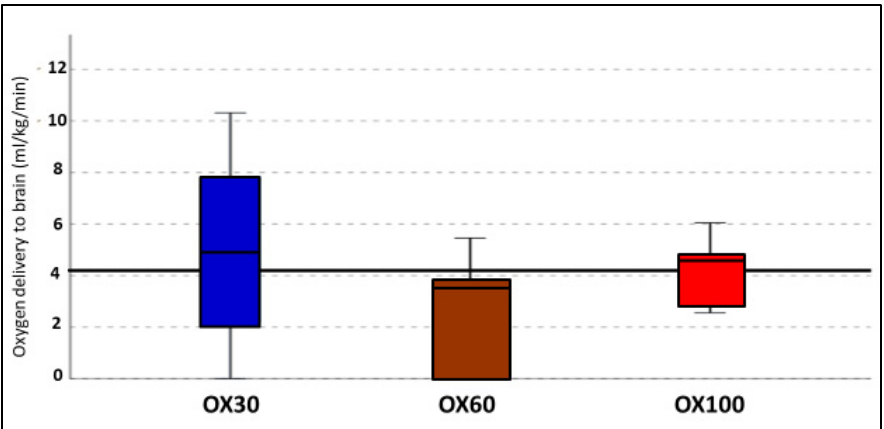
Figure 6. The oxygen delivery ( y -axis) as mL/kg/min to the brain in different groups (OX30, OX60, and OX100 ( x -axis)) are shown as box and whiskers plot. The horizontal black line plotted at 4 mL/kg/min is the median oxygen delivery in all the groups. There was wide variability in cerebral oxygen delivery with the use of OX30. There was no statistical difference between the groups.